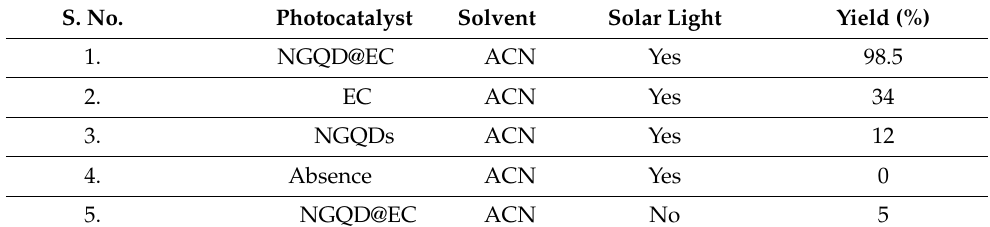
Table 1. Results of screening experiments.